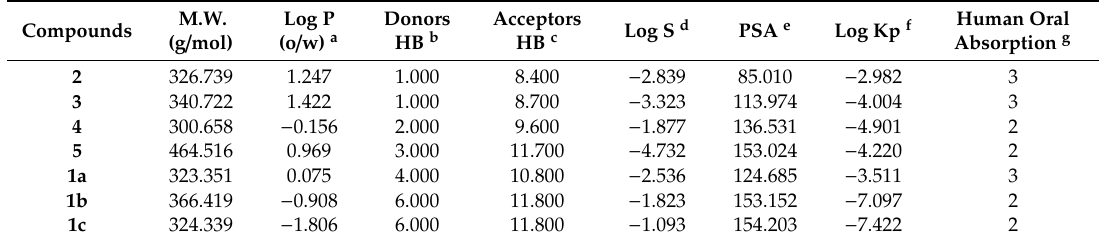
Table 8. Computer-aided absorption, distribution, metabolism, and excretion (ADME) screening of adenosine